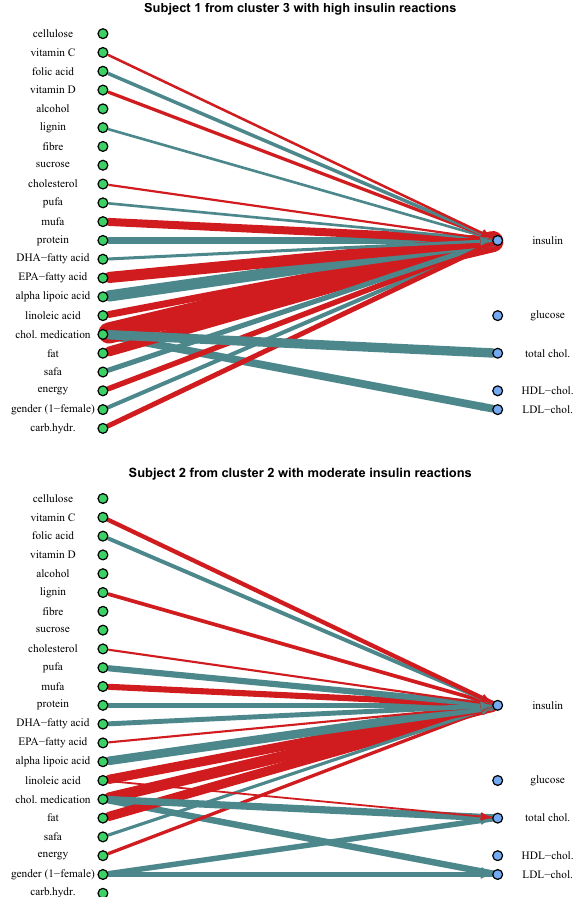
Figure 5. Two subjects were picked from differently reacting clusters and their personally predicted reaction graphs show differences from the general behaviour in Fig. 3 and with each other. The visualization shows ˆ β + ˆ b , i = 1, . . . 5, j = 1, . . . , 22, k = 1, 2 ). The red edges denote 20 most personally prominent effects ( ij ijk increasing effect and the blue edges denote a decreasing effect. Subject 1 is reacting generally with a greater increase in insulin concentration than subject 2, but there are even contradicting effects between the subjects. Vitamin D increases insulin concentration for subject 1 only and the effect of lignin is small but opposite between the subjects. The figure is plotted with iGraph package for R language (v 1.2.6, https:// igraph.